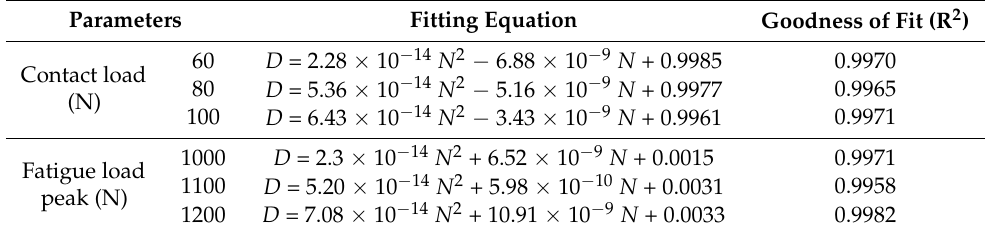
Figure 5. Fitting curves of damaged wire (pair: wire) damage degree under different contact loads ( a ) and different fatigue loads ( b ). Table 4. Fitting equation for damage degree of the fatigue wire (pair: wire).